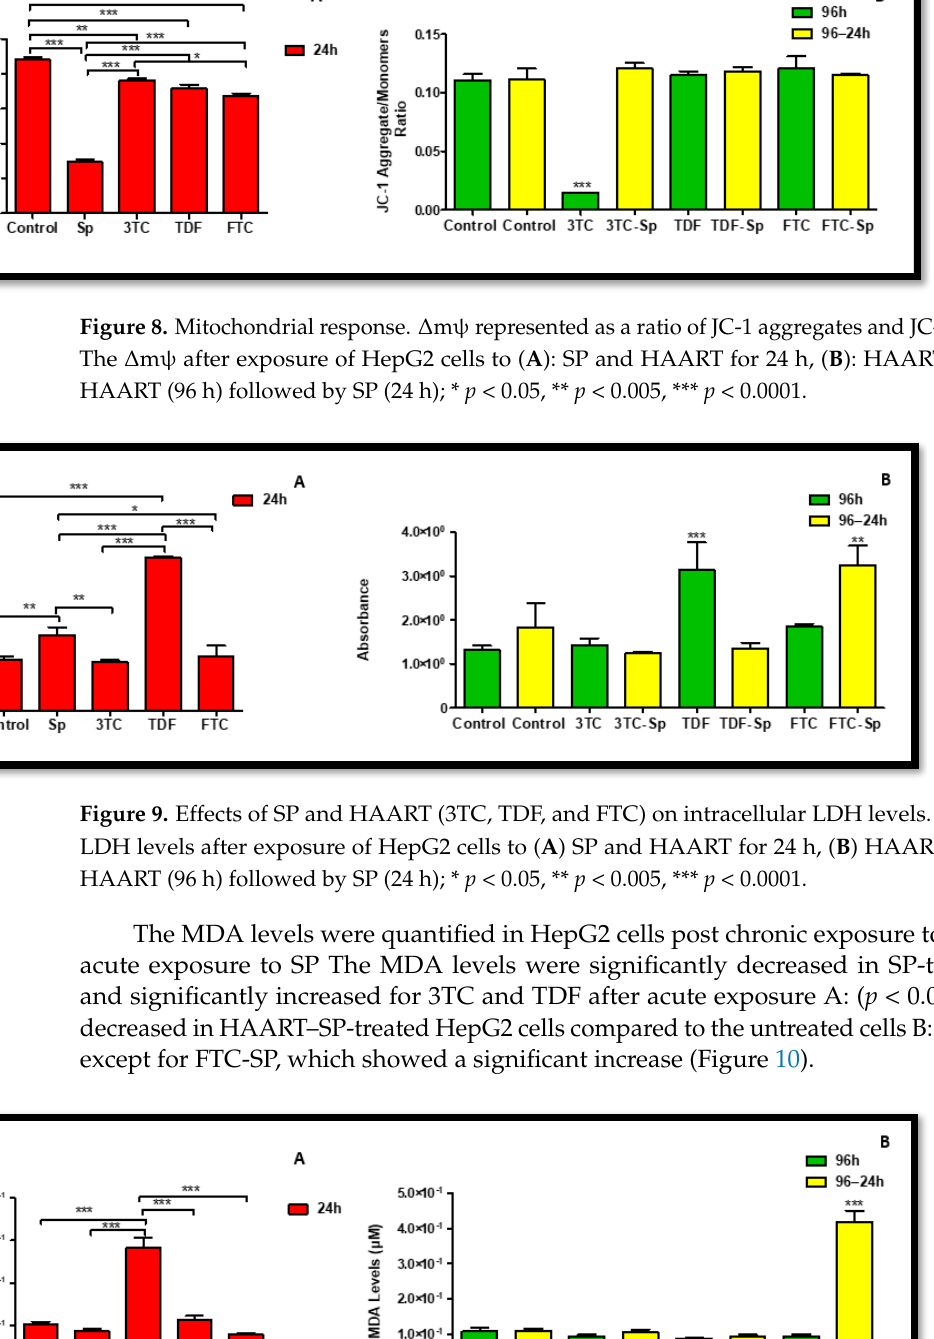
Figure 10. Extracellular MDA levels in SP and HAART (3TC, TDF, and FTC)-treated HepG2 cells. Extracellular MDA levels after exposure of HepG2 cells to ( A ) SP and HAART for 24 h, ( B ) HAART (96 h), and HAART (96 h) followed by SP (24 h); *** p < 0.0001.